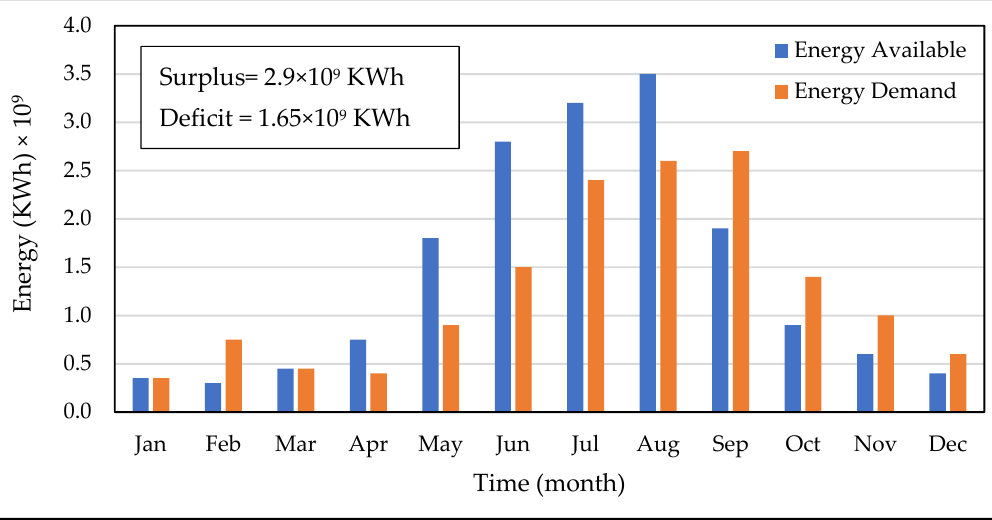
Figure 44. Comparison of Available Power Generation and Demand in 2035.